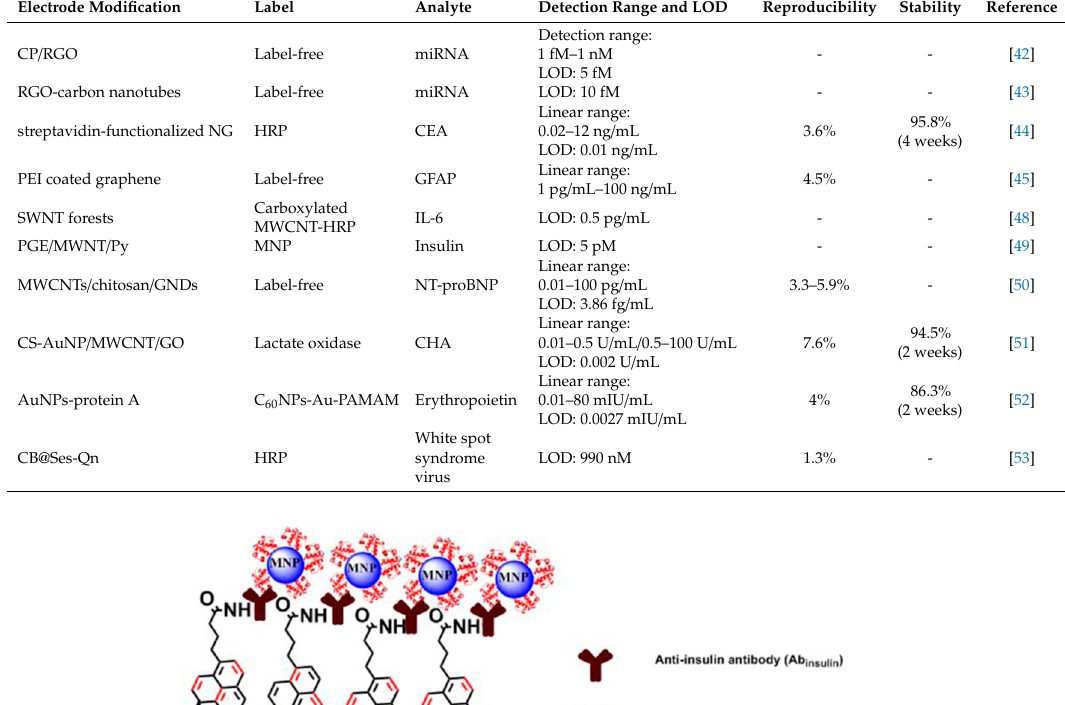
Table 1. Carbon Nanomaterials for electrochemical immunosensors.